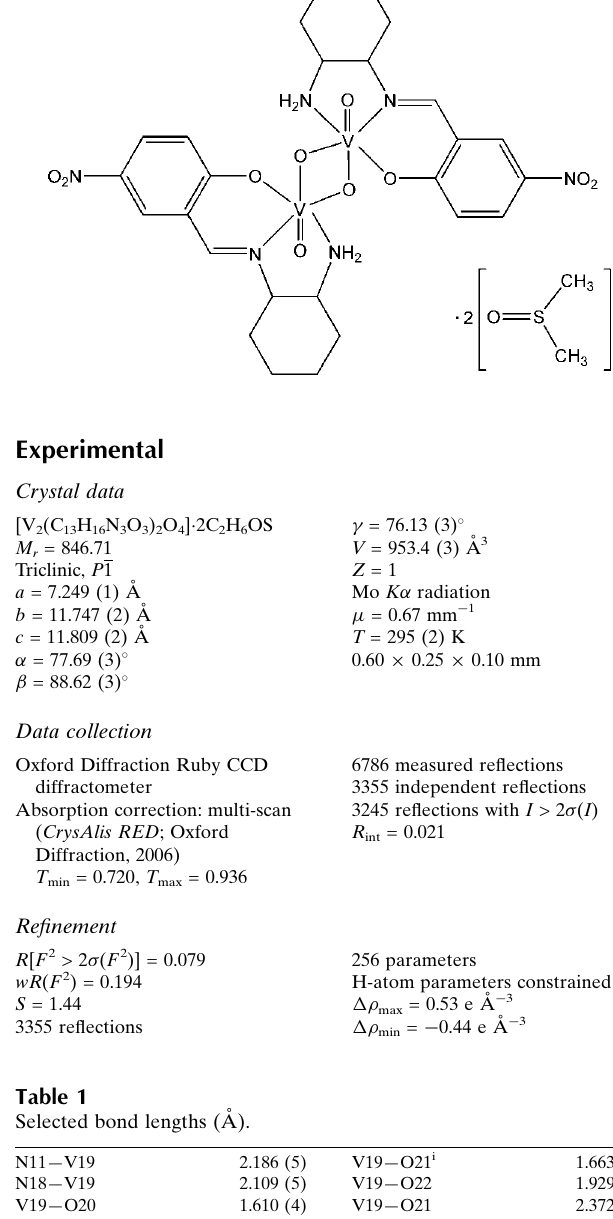
Key indicators: single-crystal X-ray study; T = 295 K; mean (cid:1) (C–C) = 0.009 A˚; disorder in main residue; R factor = 0.079; wR factor = 0.194; data-to-parameter ratio = 13.1.